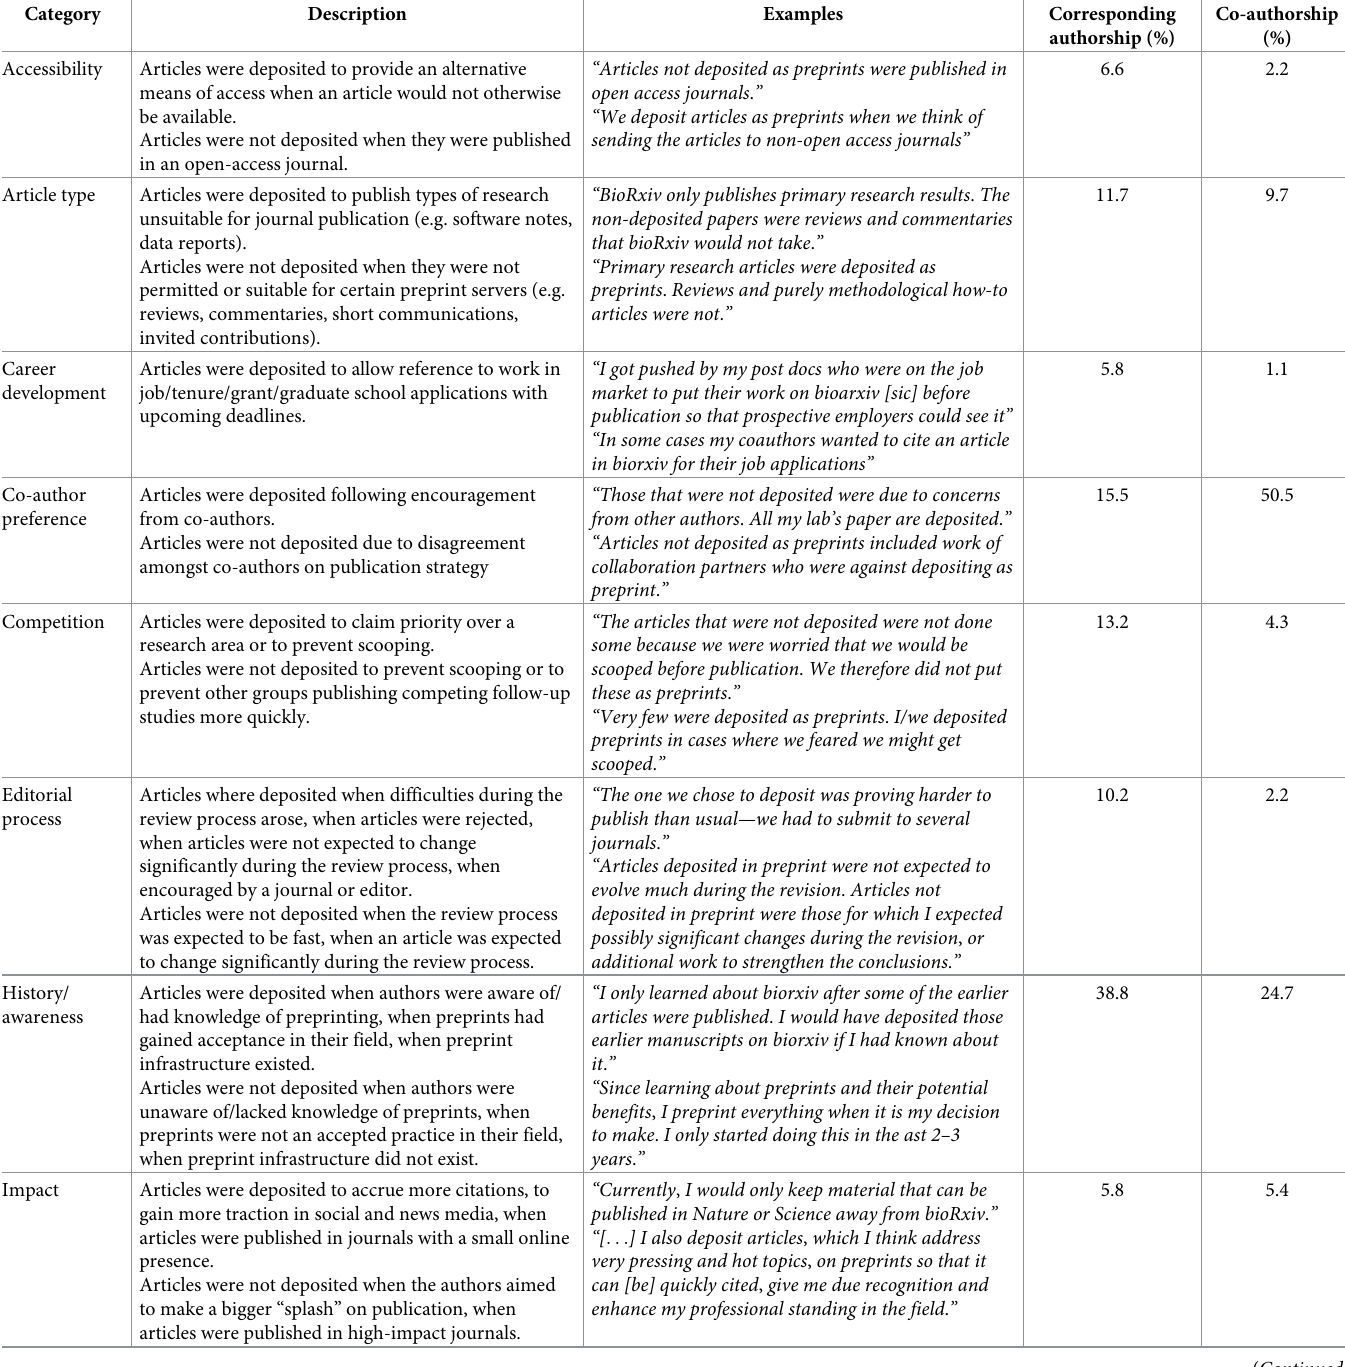
Table 8. Classification of free-text responses, in response to the question “Were there any other differences between the articles you chose to deposit as preprints versus those you did not deposit, or differences in your expectations for how the articles would be received in your community?”. Categories are ordered alphabeti- cally (except for “Other”). Percentages for corresponding and co-authorships refer to the proportion of all responses containing the relevant category; responses could con- tain multiple categories (N = 394 comments on corresponding authorships, 93 comments on